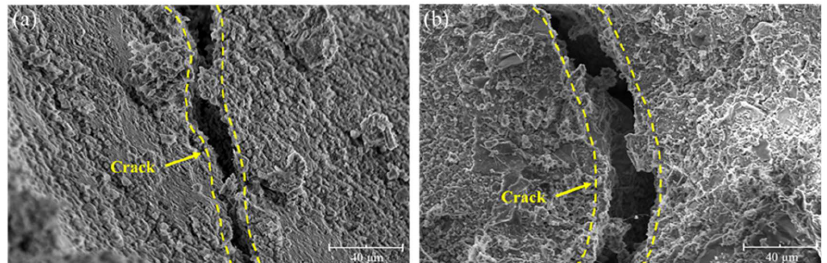
Figure 9. Micromorphology and microstructure of the samples with the pre-damage state: ( a ) crack width of 10–20 μm, ( b ) crack width of 20–30 μm.